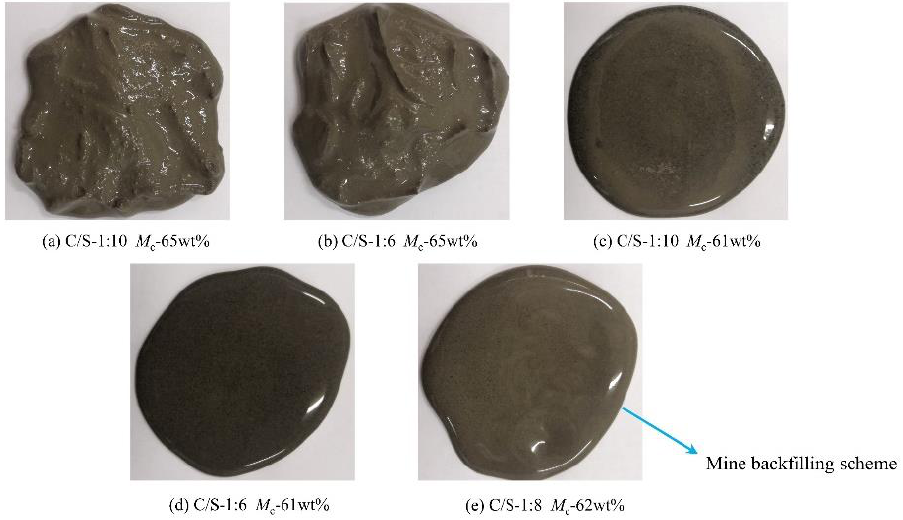
Figure 5. UCPB flow pattern.